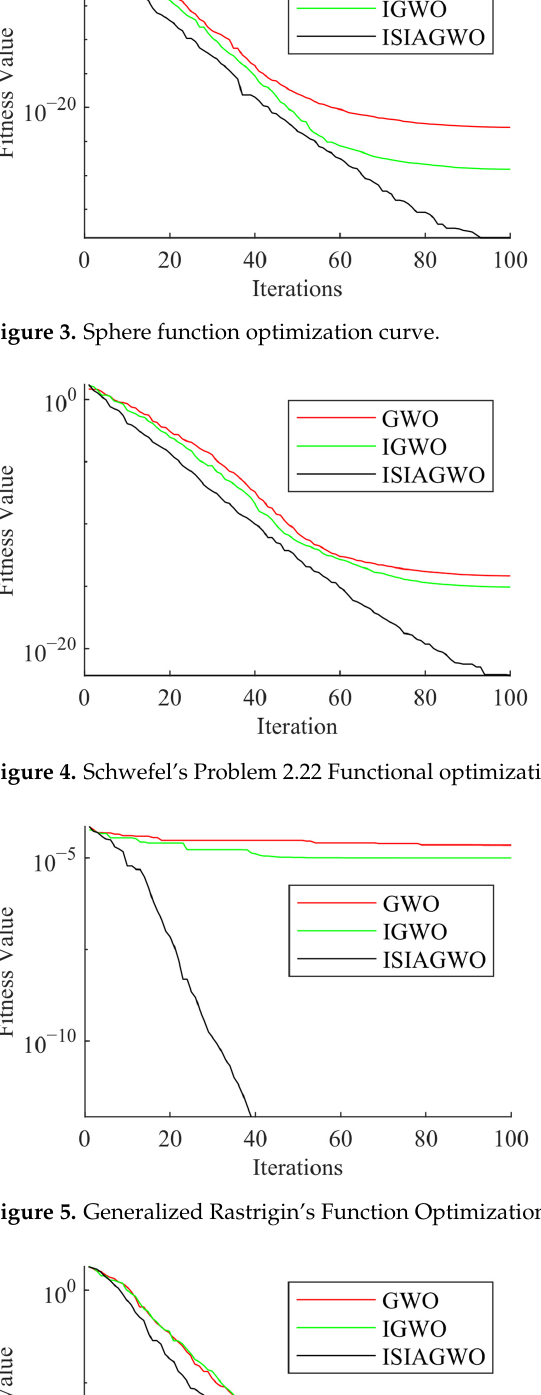
Figure 2. Images of the test function.